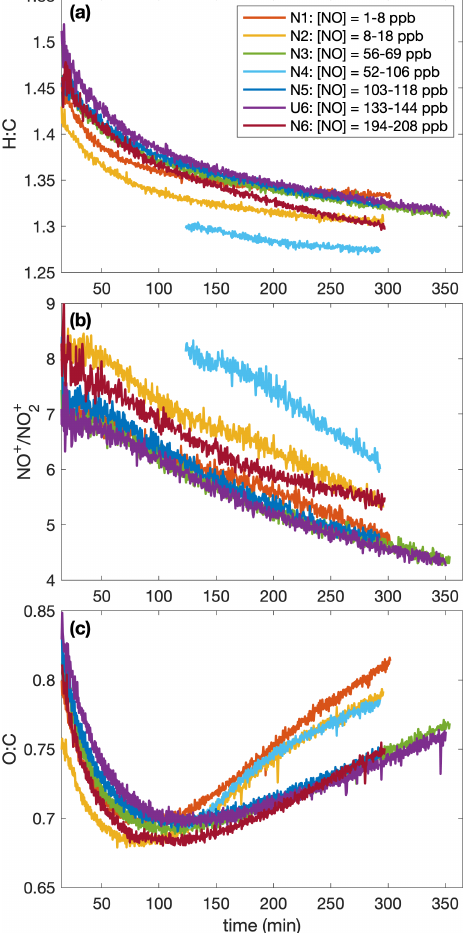
Figure 10. Variation in the (a) hydrogen-to-carbon atomic ratio, the (b) NO-to-NO 2 signal mass ratio, and the (c) oxygen-to-carbon atomic ratio indicates that the difference in SOA yield observed at different NO mixing ratios is a result of chemical differences in the aerosol formed. The lower [NO] experiments have a higher O : C ratio later in the experiment than the high [NO] ones; no trend is ob- vious in H : C ratios. Absolute uncertainties are 13% and 28% for the H : C and O : C ratios, respectively. Since the ratios are relevant only when there is a sufficient amount of aerosol present, the first 15min after oxidation are not shown. Data were collected only after ∼ 2h of oxidation for experiment N4. A SOA yield is not calculated for experiment U6 due to uncertainties in the rate of particle-wall deposition, but that should not affect the chemical composition of the